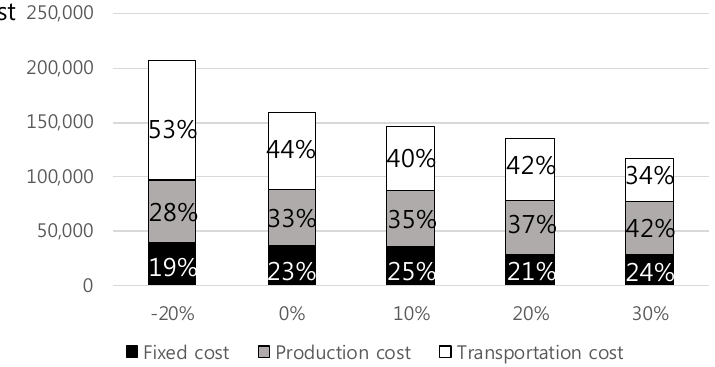
Figure 7. Cost comparison based on capacity change.